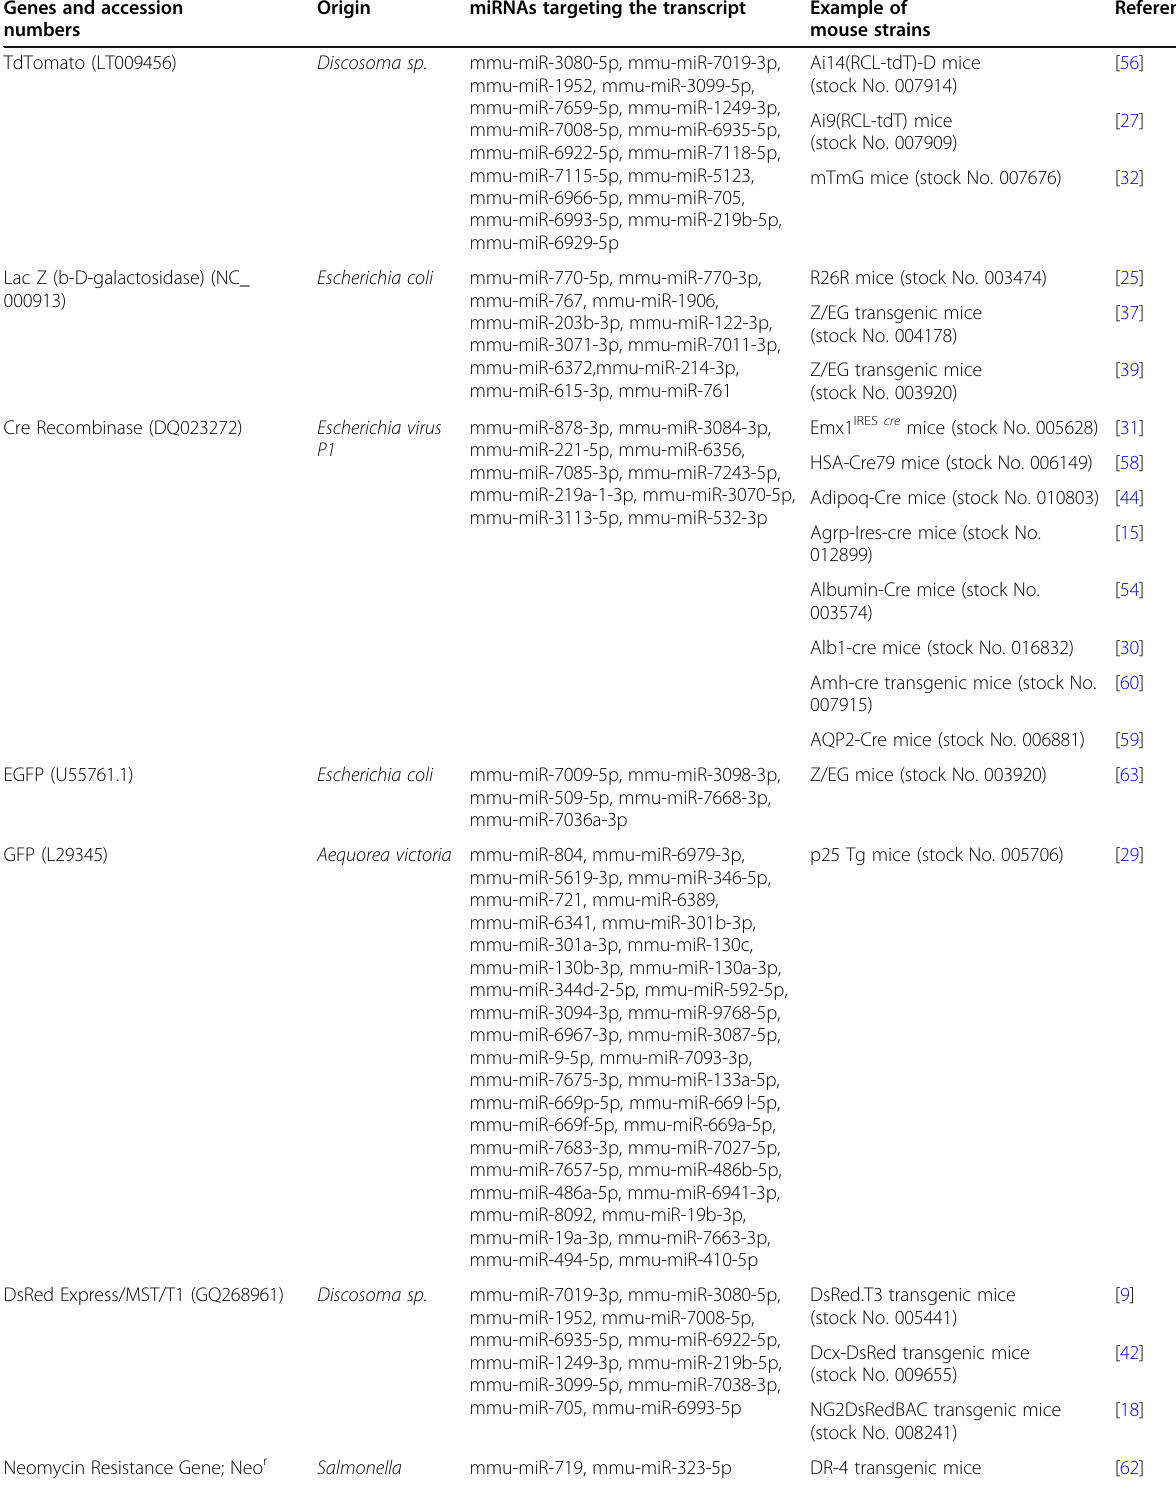
Table 1 Mus musculus miRNAs against inserted foreign genes and corresponding transgenic mice. Reporter genes like Neo r , LacZ, Cre recombinase, DsRed, and TdTomato have widely been used to generate transgenic mice. However, due to their non- mammalian origin, (e.g., DsRed from Discosoma sp. , GFP from Aequorea victoria , and LacZ from Escherichia coli K12), most of these genes may be potentially targeted by Mus musculus miRNAs once expressed in transgenic